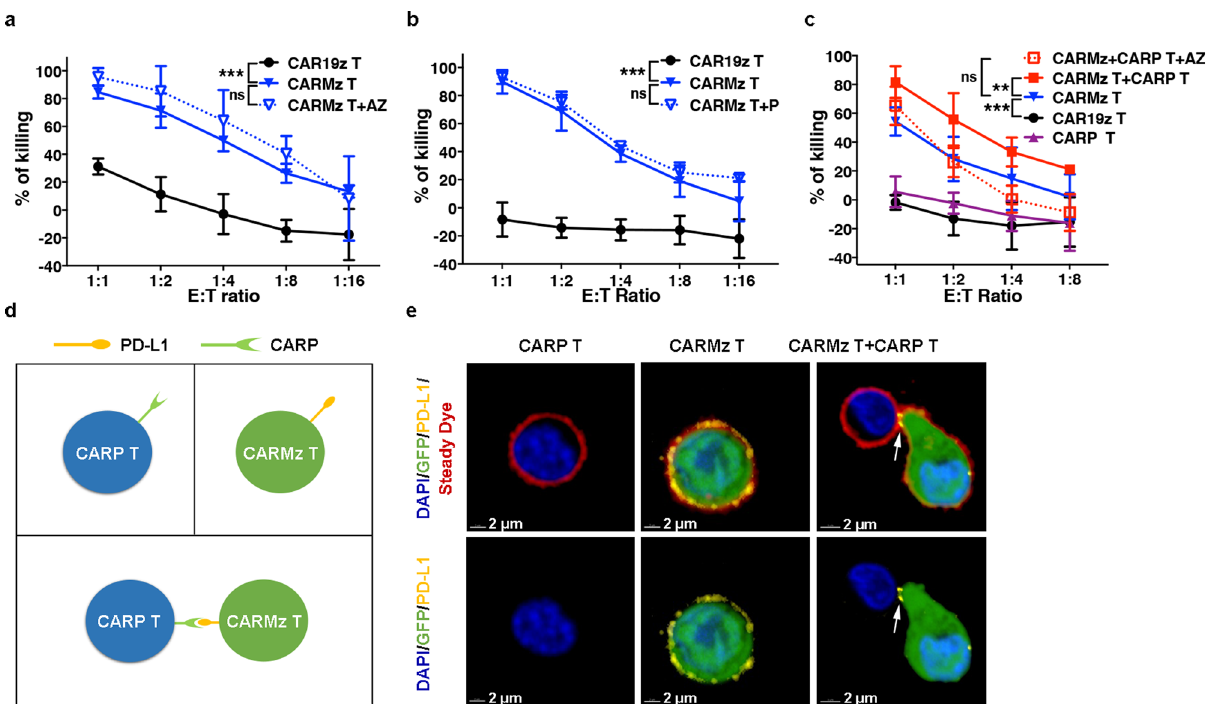
Fig. 2 | Formationofcell – cell connectionsbetween CARMz T and CARPT cells. a CARMz T and CAR19z T cells with or without an anti-PD-L1 mAb (AZ, 20 μ g/ml) against HeLa-GL cells were measured at various E:T ratios. p Values (CAR19z T vs. CARMzT=7.499E − 10,CARMzT+AZvs.CARMzT=0.164). b CARMzTandCAR19z T cells with or without an anti-PD-1 mAb (P, 20 μ g/ml) against HeLa-GL cells were measured at various E:T ratios. p Values (CAR19z T vs. CARMz T=5E − 14, CARMz T+Pvs.CARMzT=0.084). c CARMzT,CARPT,amixtureofCARMzTandCARPT, a mixtureof CARMz T and CARP T treatedwith anti-PD-L1mAb (AZ, 20 μ g/ml) and controlCAR19z T cells against HeLa-GLcellsweremeasured at various E:Tratios. p Values (CAR19z T vs. CARMz T=3.309E − 07, CARMz T+CARP T vs. CARMz T=0.001,CARMzT+CARPT+AZvs.CARMzT=0.939).Dataof a – c arepresented